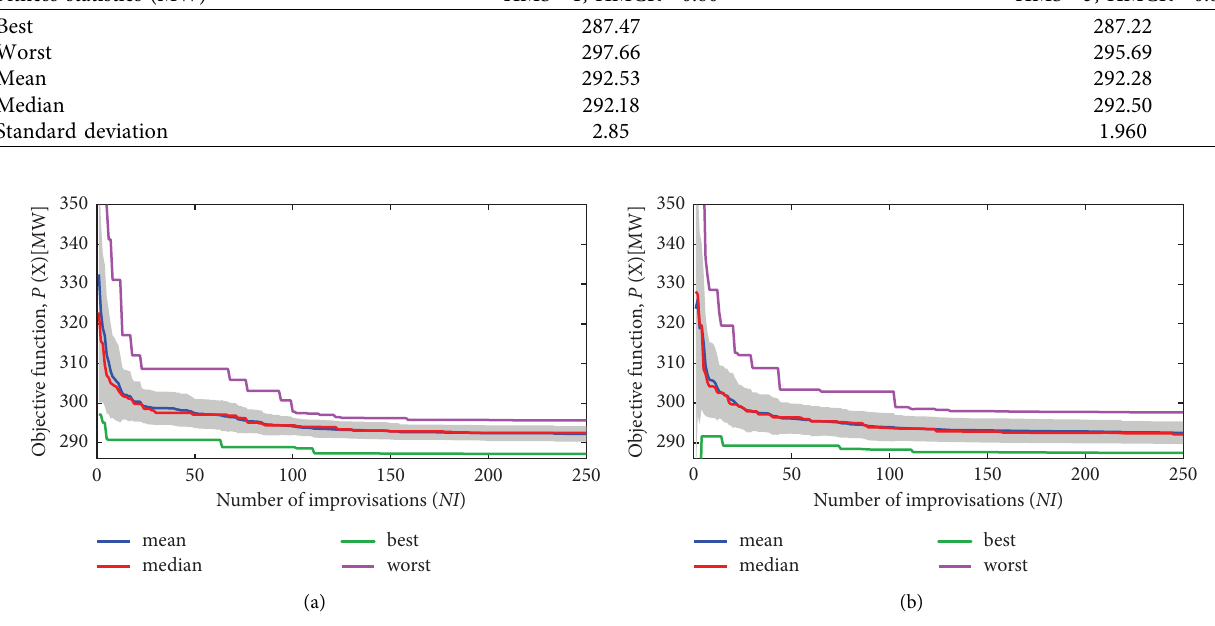
Table 2: Best, worst, mean, median, and standard deviation values, in MW, obtained through 30 independent runs of the IHS algorithm. Fitness statistics